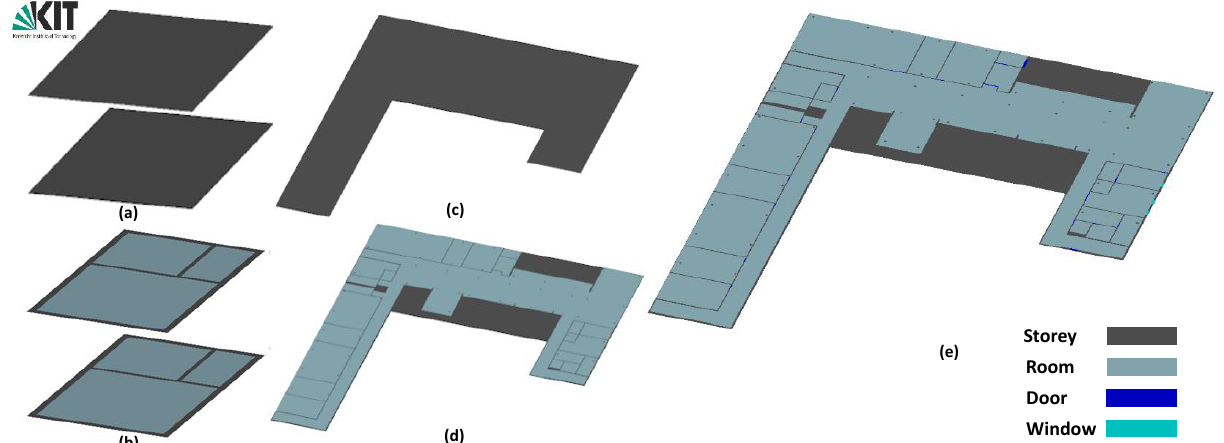
Figure 12. Various variants generated as a result of implemented geometric computation (FZK Viewer).